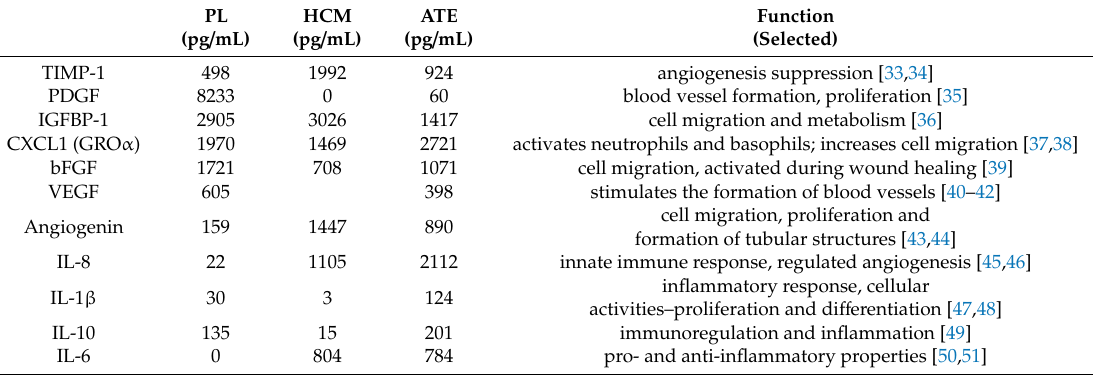
Figure 1. Protein and cytokine array data. ( A ) Angiogenesis protein array profile, ( B ) cytokine array profile and ( C ) mean pixel density of selected proteins plotted as circles (the larger the circle, the higher the mean pixel density). Table 2. ELISA results of selected proteins of bioactive factors derived from adipose tissue (ATE), platelet lysate (PL) and conditioned medium from hypoxia-treated immortalized bone-marrow-derived mesenchymal stromal cells